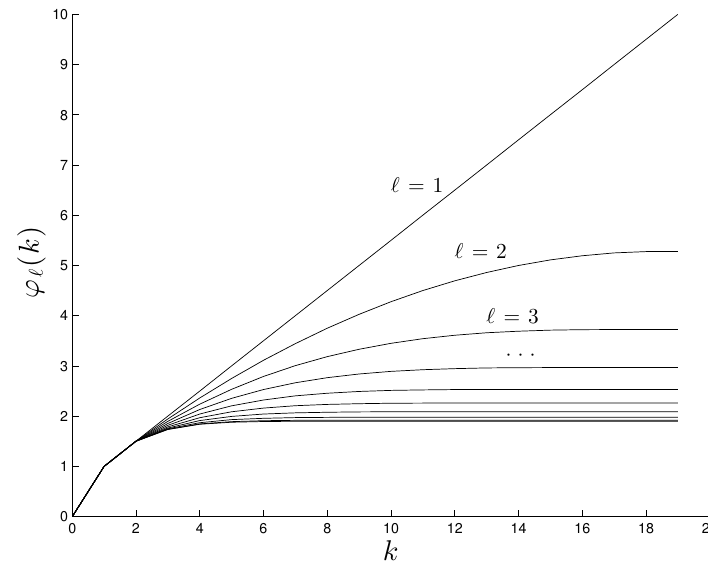
Figure 2: The values of φ (cid:96) ( k ) for (cid:96) = 1, . . . , n /2 , for n = 20